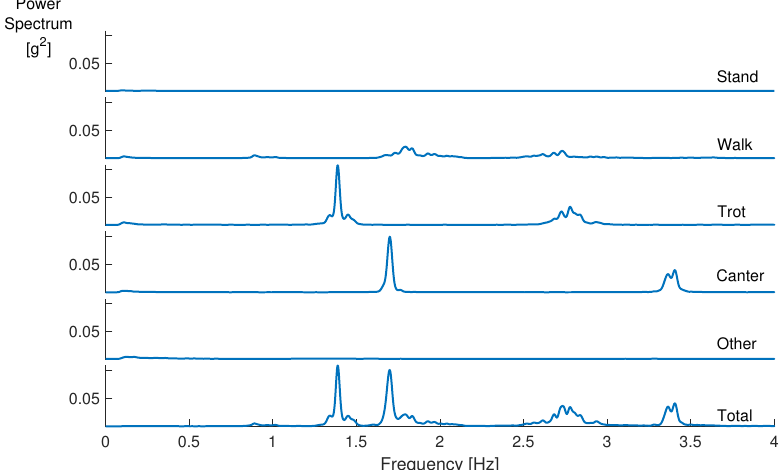
Figure 3. The total power spectrum is the sum of the separate spectra for dataset 19. For canter the maximum lies at a higher frequency as for trot. Both gaits contribute to the general spectrum of the dataset.